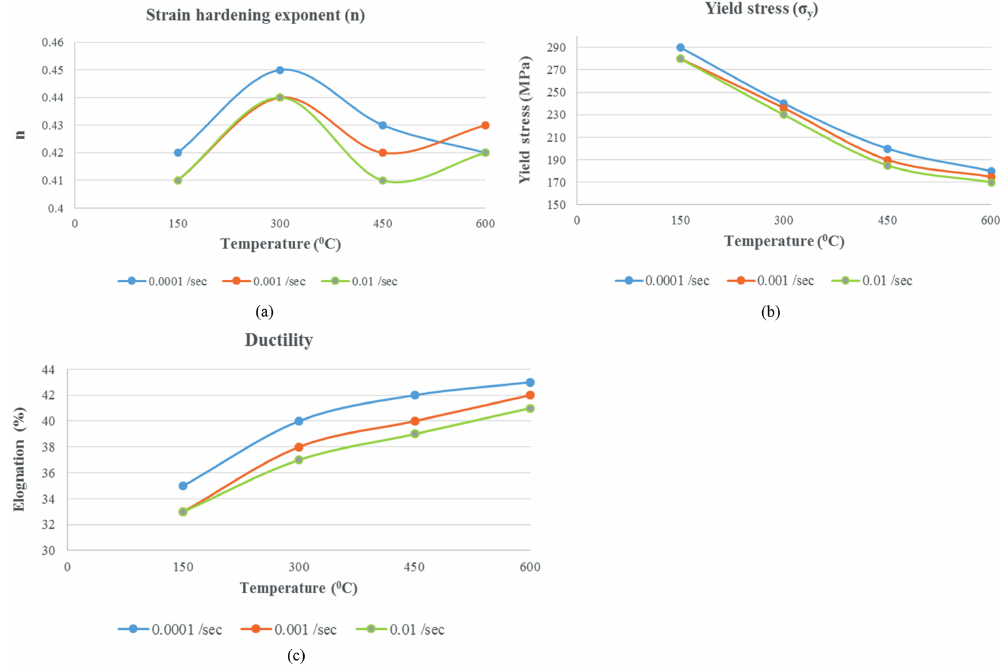
Figure 12: Variation of material properties of ASS 316 with respect to temperatures for different strain rates (a) Strain hardening exponent (b) Yield stress (c) %